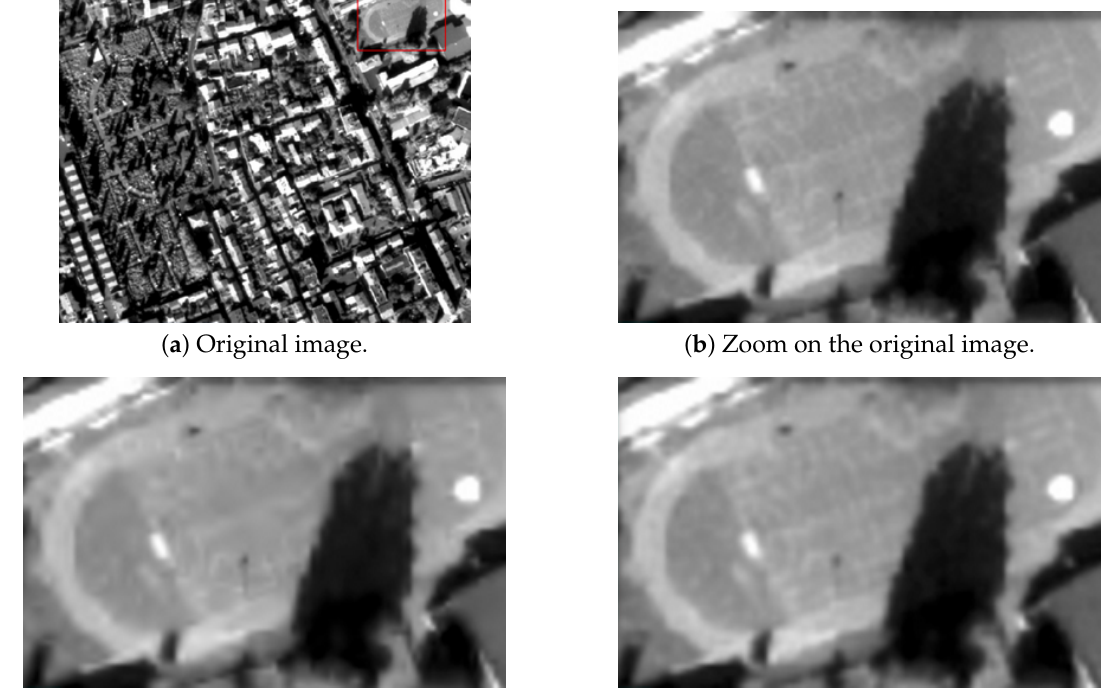
Figure 9. Subjective image quality analysis—R = 2.02